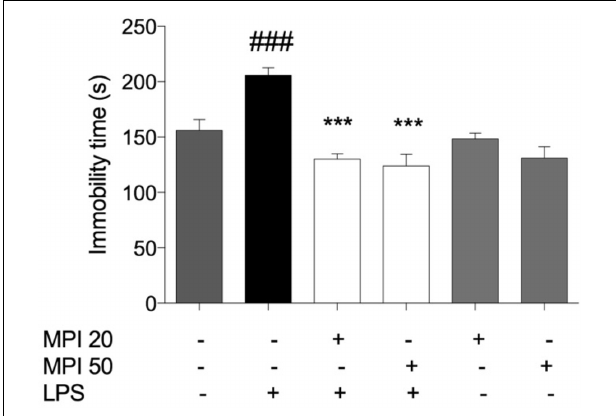
FIGURE 3 | Effects of MPI on the depressive-like behaviors induced by LPS. After 24 h of LPS administration, the LPS-induced group had significantly increased the immobility time measured in the FST compared to the control group ( F 5 , 30 = 12.22, P < 0.001, post hoc ### P < 0.001, n = 6) (###). MPI followed by LPS administration prevented the increase in the immobility time when compared to the LPS-induced group ( F 5 , 30 = 12.22, P < 0.001, post hoc ∗∗∗ P < 0.001, n = 6) ( ∗∗∗ ). No significant differences observed among the control and MPI followed by saline admnistration. Data were analyzed using a one-way ANOVA followed by the Student–Newman–Keuls multiple comparisons post hoc test. Error bars represent SEM.